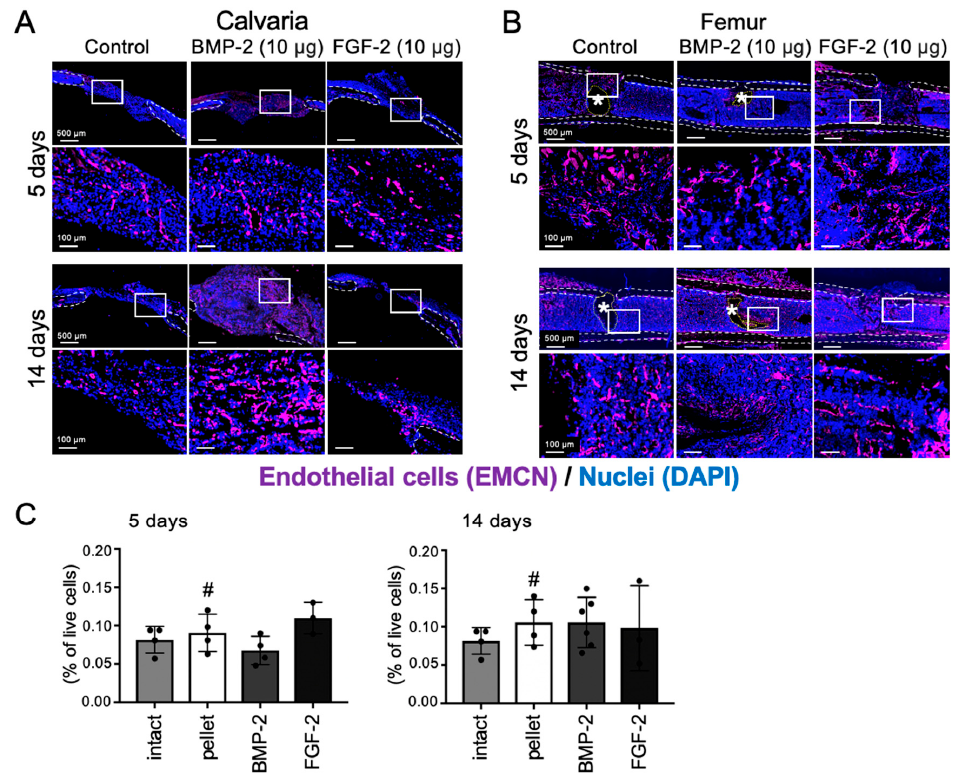
Figure 5. E ff ects of BMP-2 and FGF-2 on angiogenesis in mouse calvarial and femoral defect. Cross-sectional frozen sections of calvaria (frontal plane, A ) and femurs ( B ) obtained from wild-type mice after 5 and 14 days of collagen pellet implantation. EMCN-positive endothelial cells are shown in purple. Dashed lines indicate the cortical bone (white) and the remained collagen pellet (*, yellow). Nuclei were stained with DAPI (blue). The results are representative of at least three independent experiments. Collagen pellets containing BMP-2 (10 µ g) or FGF-2 (10 µ g) or DW (control) were transplanted into mouse femur defects and samples were analyzed by FCM ( C ) at 5 days and 14